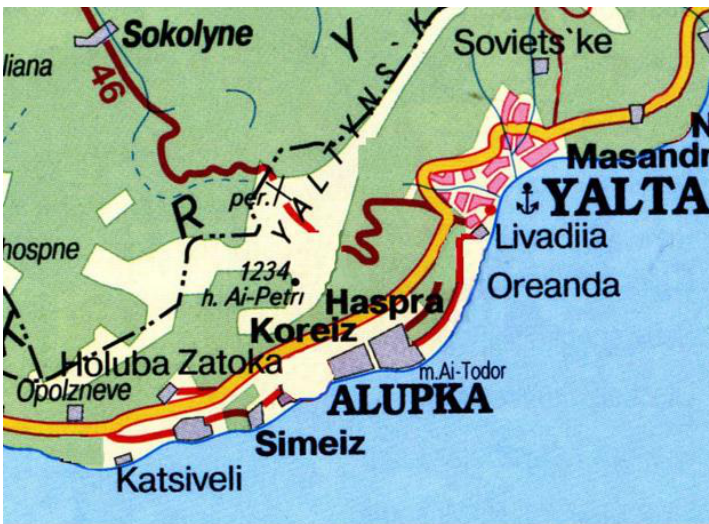
Fig. 1. The “Simeiz-Katsively” test area.